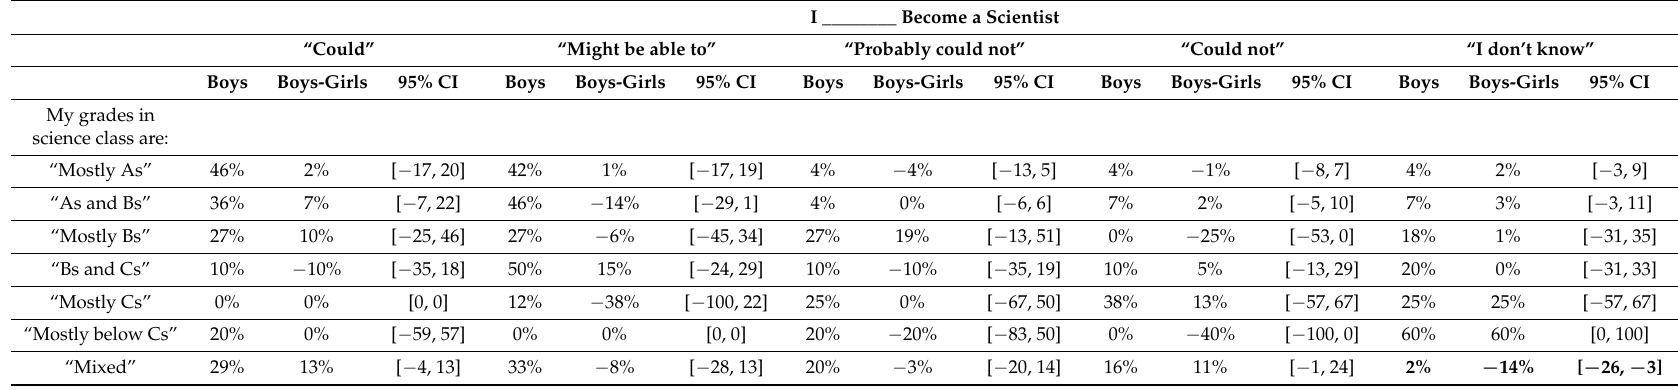
Table 2. Cross-tabulation of self-reported science grades and self-perceived science potential (I “could”/ “might be able to”/”probably could not”/”could not”/” I don’t know if I would be able to” become a scientist) by Gender.